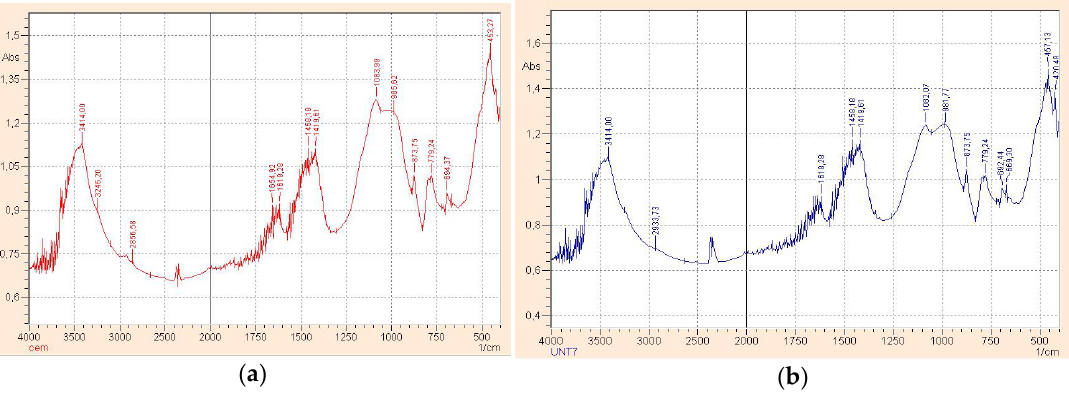
Figure 5. Results of IR-spectral analysis of samples: control composition ( a ), modified composition ( b ). Table 1. Information of positions from FTIR.